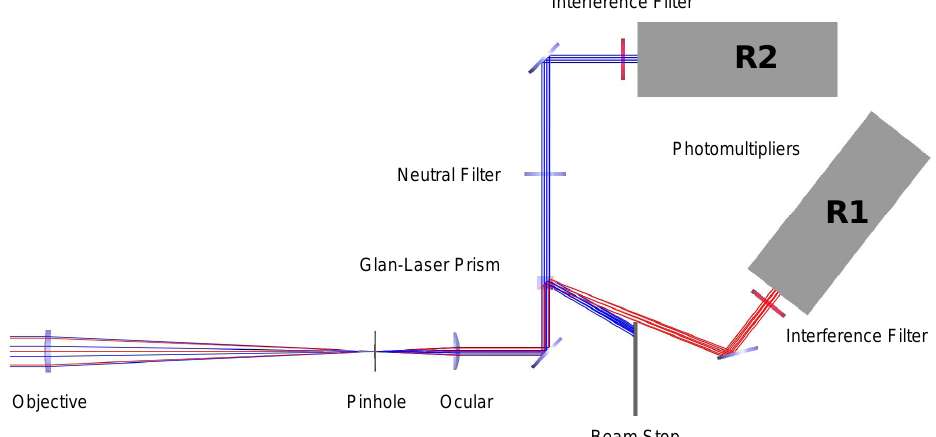
Fig. 3. Backward detection setup composed of telescope optics, Glan-Laser prism, neutral filter (wheel), and two photomultiplier detectors (R1, R2).